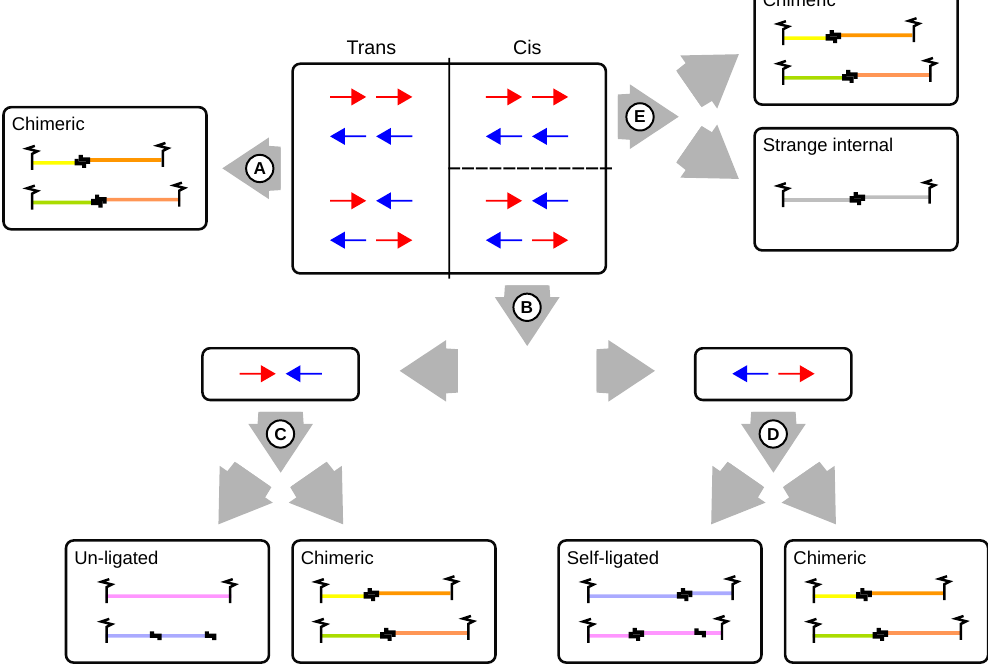
Figure 6. Processing logic for read pair filtering. Trans reads by definition are chimeric fragments and may represent valid biological interactions or random cross-ligation events ( A ). Pairs mapping to different strands of the same chromosome may originate from un-ligated or self-ligated digests ( B ). Inward pointing pairs that map to the same digest must have originated from un-ligated fragments. A size threshold is applied to the remaining fragments to categorize them as valid or artefactual ( C ). Outward pointing read pairs that map the same digest must have originated from self-ligated digests. A second size threshold is applied to the remaining fragments to categorize them as valid or artefactual ( D ). Read pairs mapping to the same strand can only be chimeric. However, we observe very small proportions of read pairs that are mapped to the same strand and digest. Such read pairs are classified as strange internal ( E